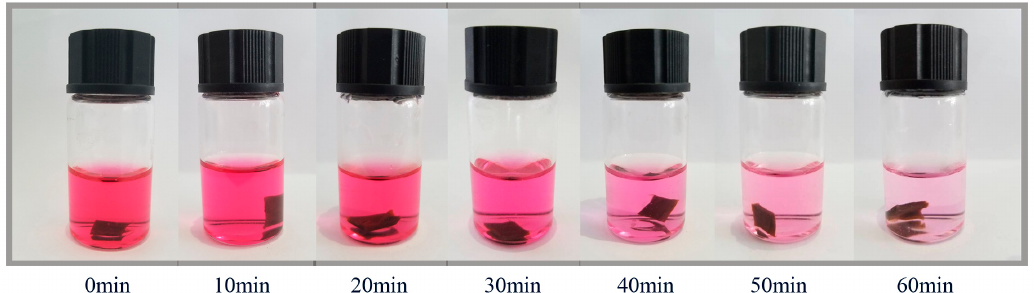
Figure 8. Typical optical image changes of reactive red X-3B (initial concentration 100 μ M, pH = 2, T = 50 °C) with CoPc@s-BC (1 mg) and H 2 O 2 (8 mM).